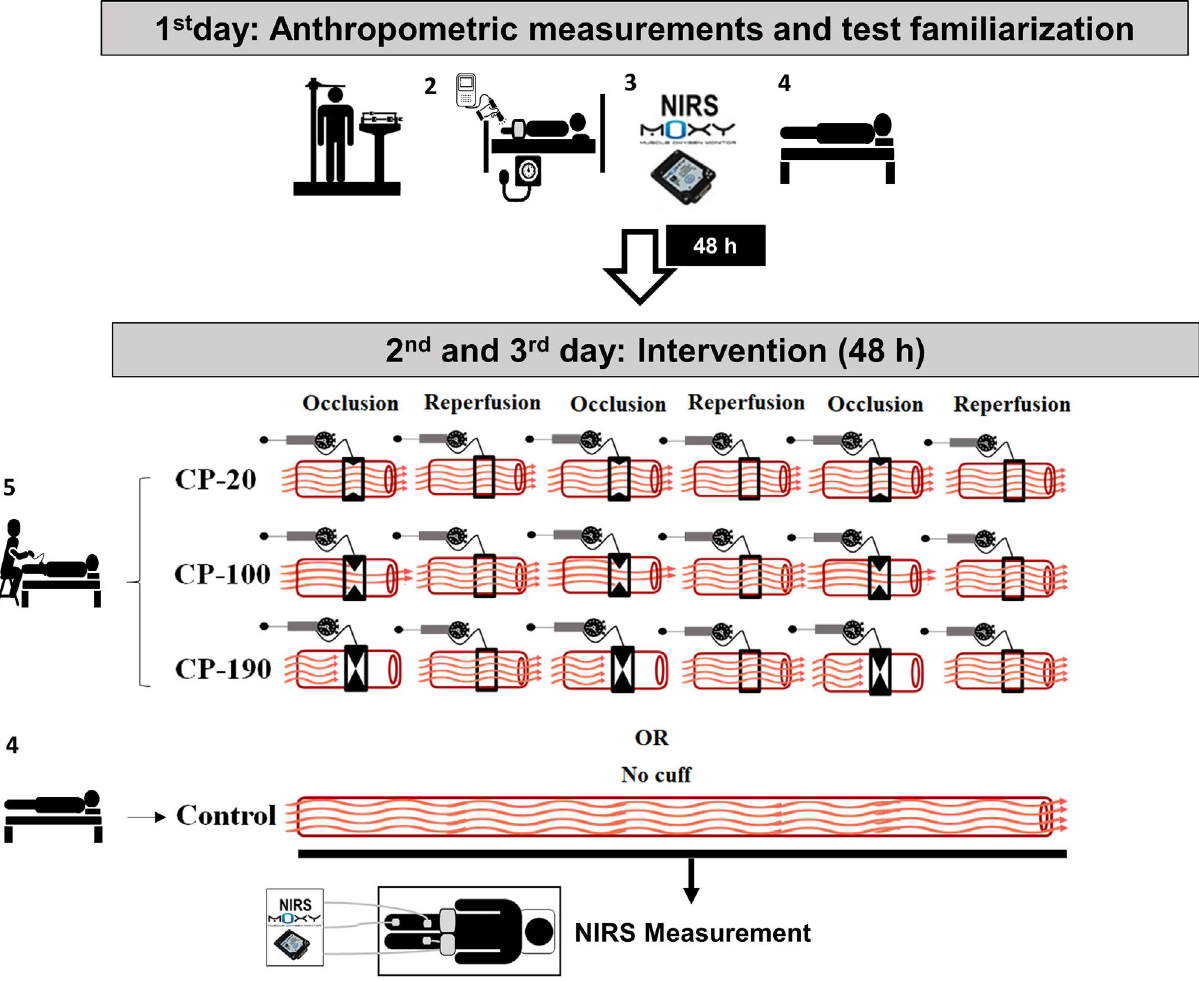
Figure 1 - Experimental Design. CP-190, cuff-pressures of 190 mmHg; CP-100, cuff-pressures of 100 mmHg; CP-20, cuff-pressures of 20 mmHg; 1, Anthropometric measurements; 2, Arterial occlusion pressure check; 3, NIRS device placement; 4, Control condition (no cuff); 5,